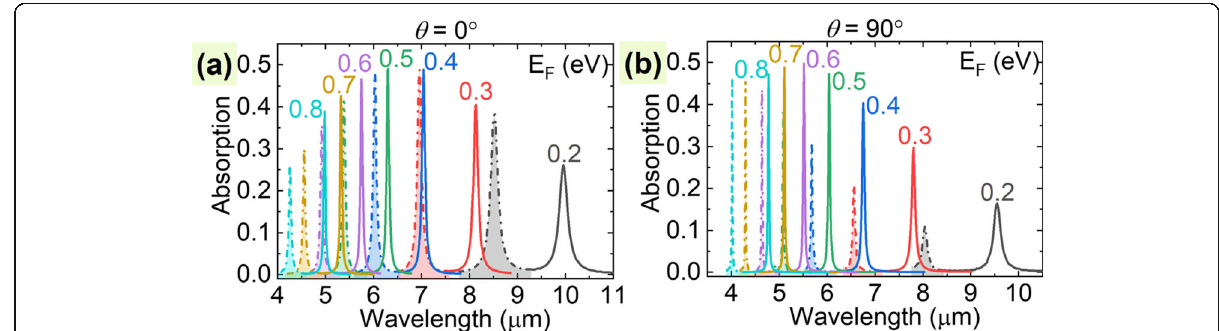
Fig. 4 Absorption spectra of the symmetric mode (solid lines) and antisymmetric mode (dash-dotted lines) of the proposed PIT system with different Fermi energy levels of graphene at polarization angles of θ = 0° ( a ) and 90° ( b ),